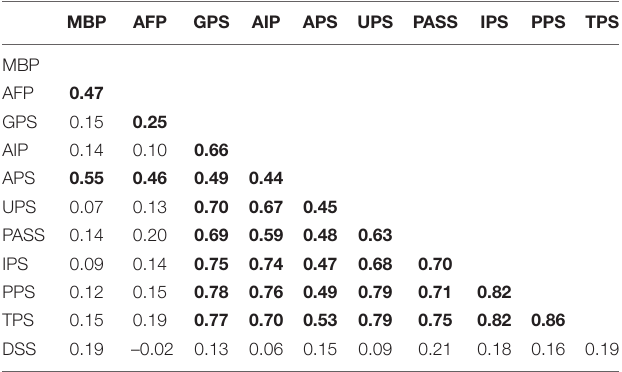
TABLE 5 | Summary of the confirmatory factor analysis (CFA) and measurement invariance (MI) models for all self-report procrastination